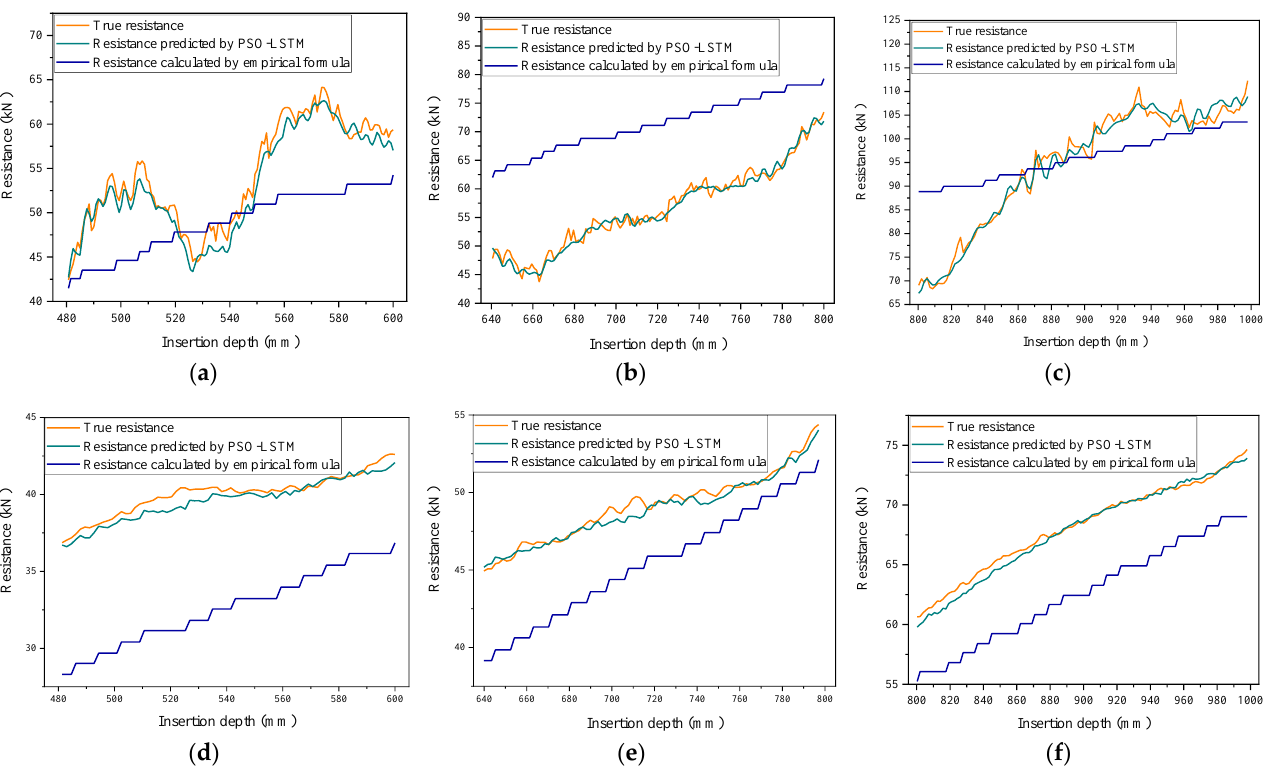
Figure 23. Resistance comparison. ( a ) The gravel pile with an insertion depth of 600 mm; ( b ) The gravel pile with an insertion depth of 800 mm; ( c ) The gravel pile with an insertion depth of 1000 mm; ( d ) The sand pile with an insertion depth of 600 mm; ( e ) The sand pile with insertion depth of 800 mm; ( f ) The sand pile with insertion depth of 1000 mm.